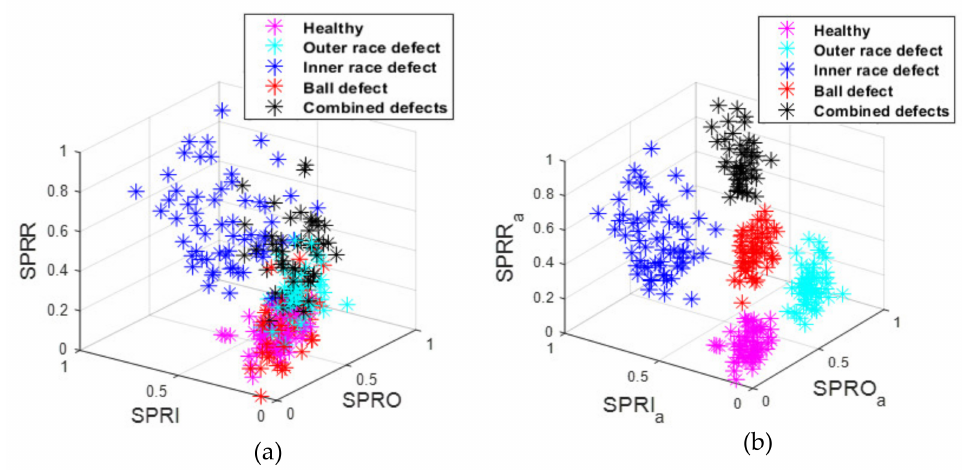
Figure 9. Space representation of the acquired pre-processed data: ( a ) as a function of the conventional features; ( b ) as a function of the updated features.